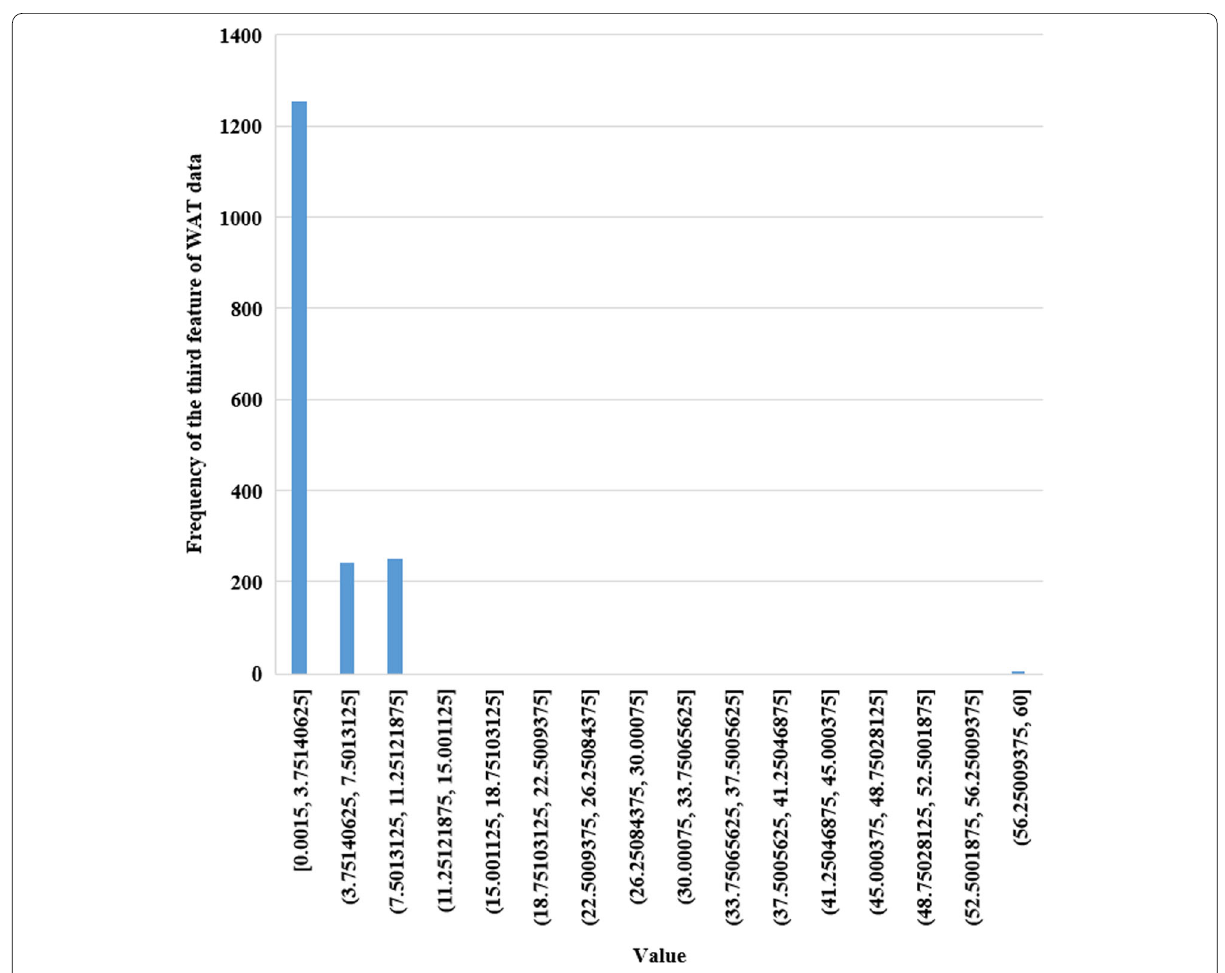
Figure 5 Third original feature data distribution of WAT